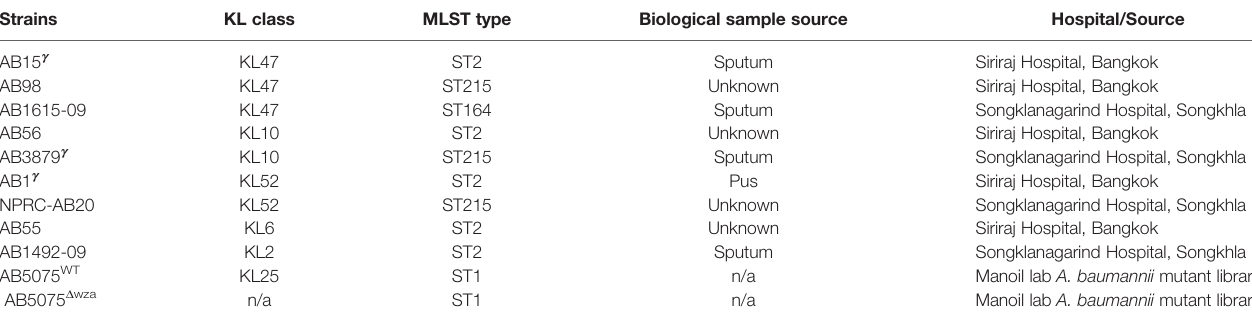
TABLE 1 | A. baumannii isolate information.